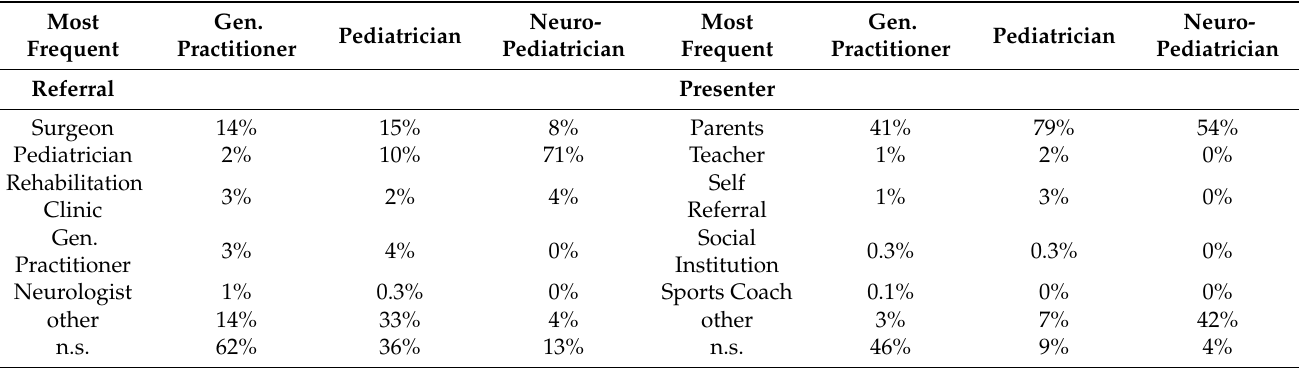
Table 2. Distribution of referrals and presenters of patients with acute TBI among the different specialties.